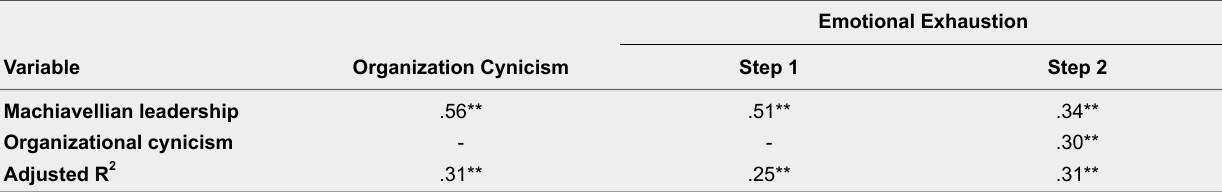
Regression Results for Testing